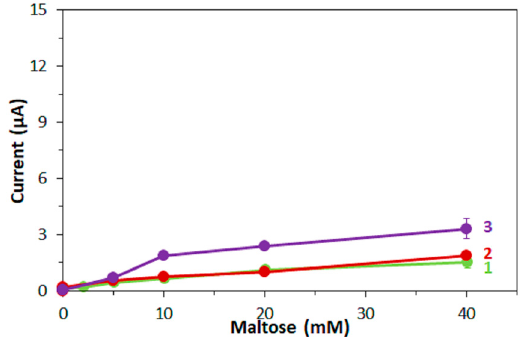
Figure 4. Dependency of current at 5 s after application of the potential on the maltose concentration. Enzyme: FADGDH γαβ (QY). Mediator: (1) 100 mM mPMS, (2) 100 mM ferricyanide, (3) 100 mM hexaammineruthenium(III).